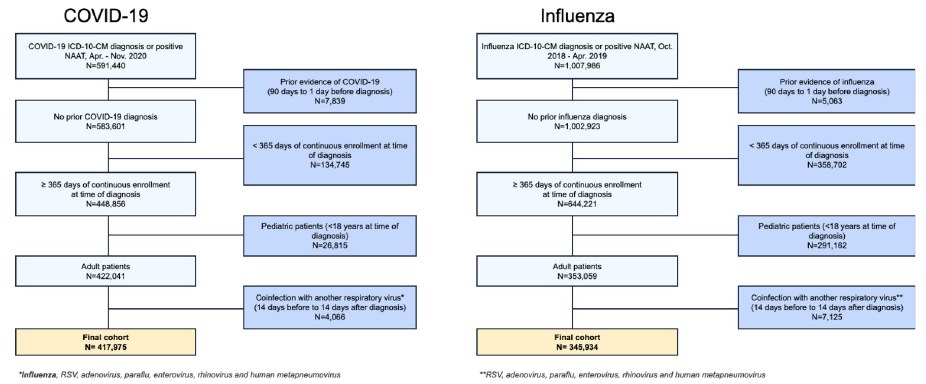
Fig 1. Cohort selection diagram for the COVID-19 cohort (a) and for the influenza cohort (b). Abbreviations: ICD- 10-CM—international classification of diseases, 10th revision; NAAT—nucleic acid amplification